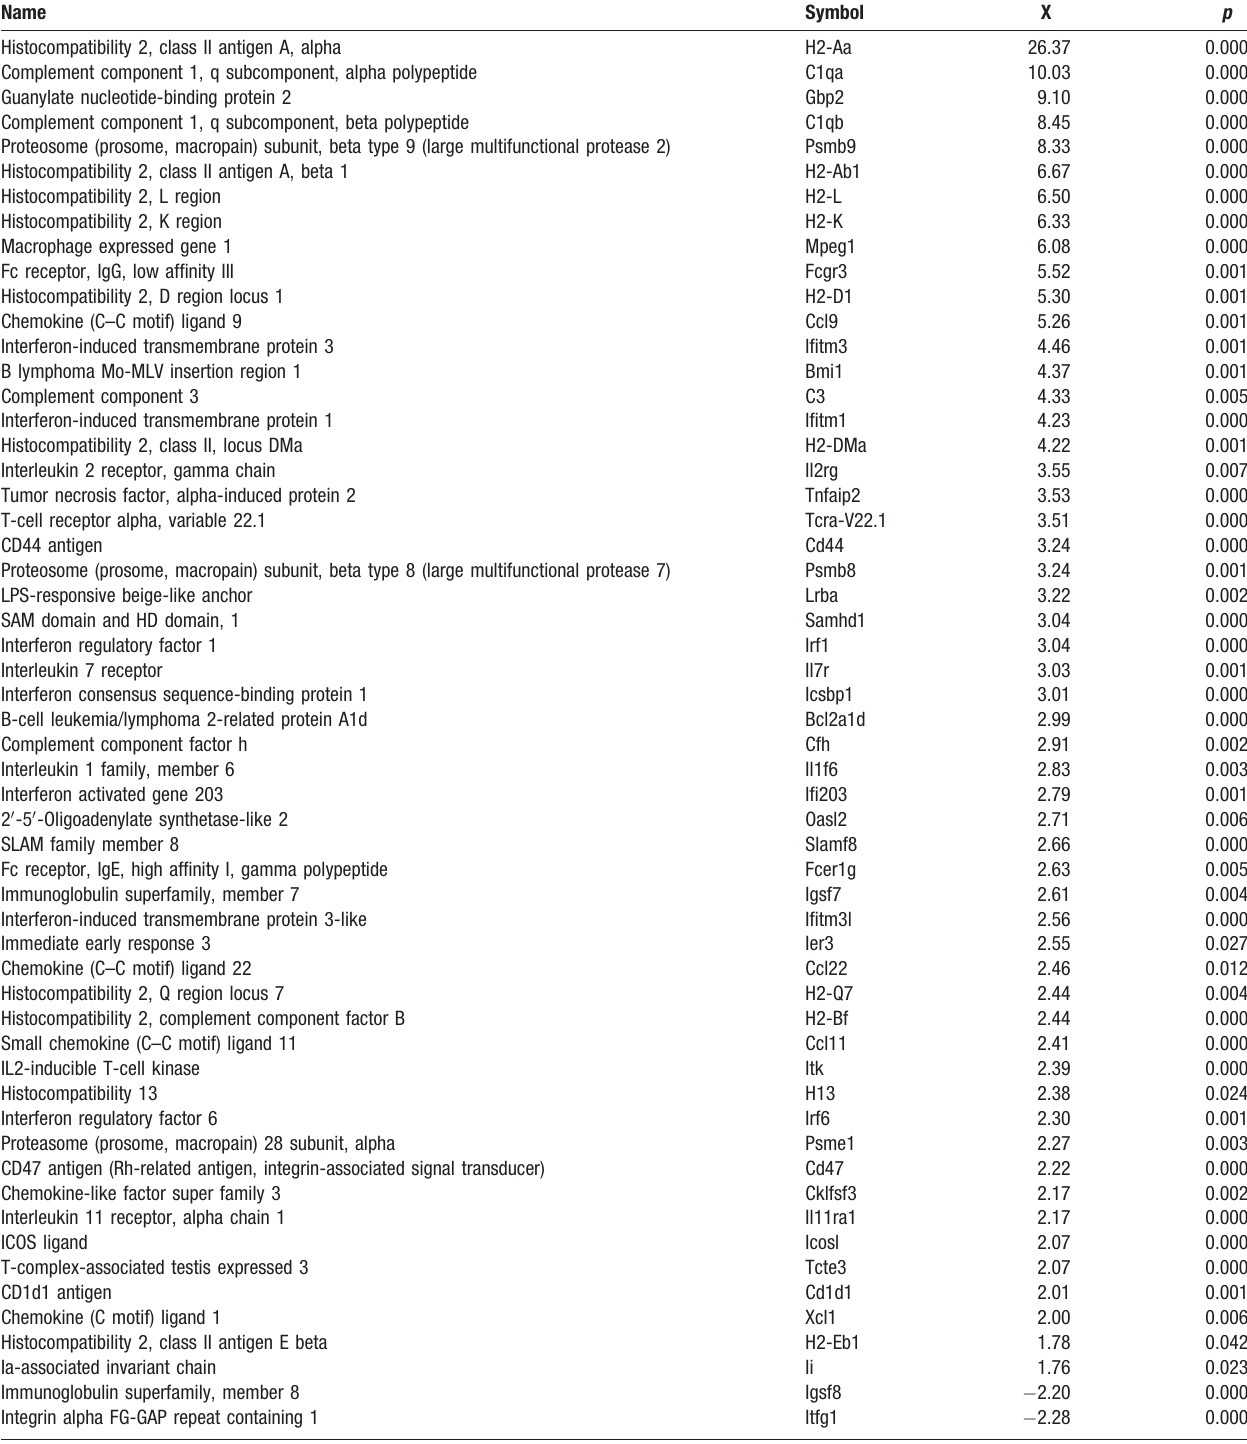
Table 1. Regulation of immune response genes in AT-EAE spinal